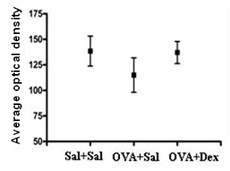
Immunohistochemistry analysis of PTEN protein by average optical density (mean ± SD). Bars, 25 μm.